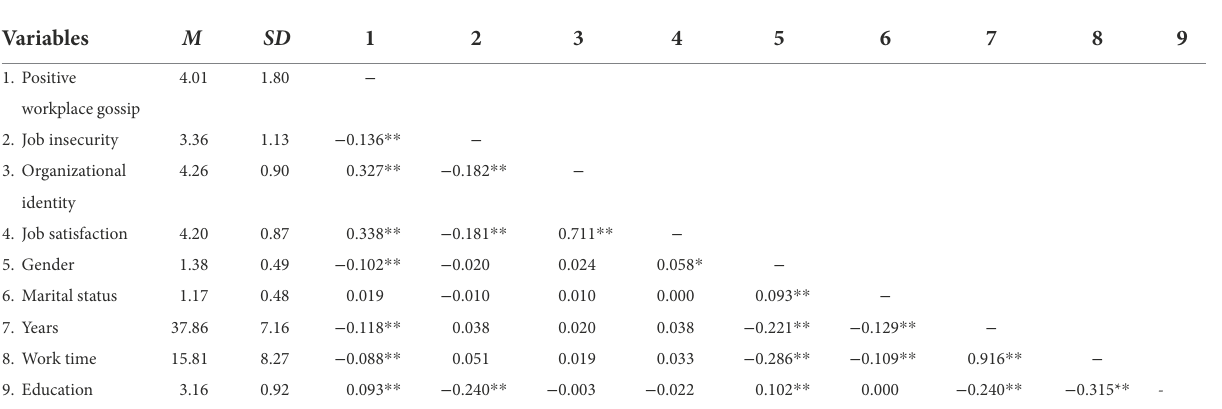
TABLE 1 Describes statistics.